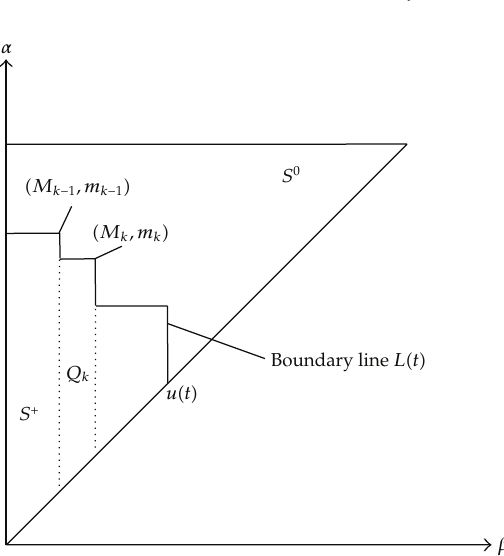
Figure 7: Numerical implementation of the Preisach model in the case of increasing input.